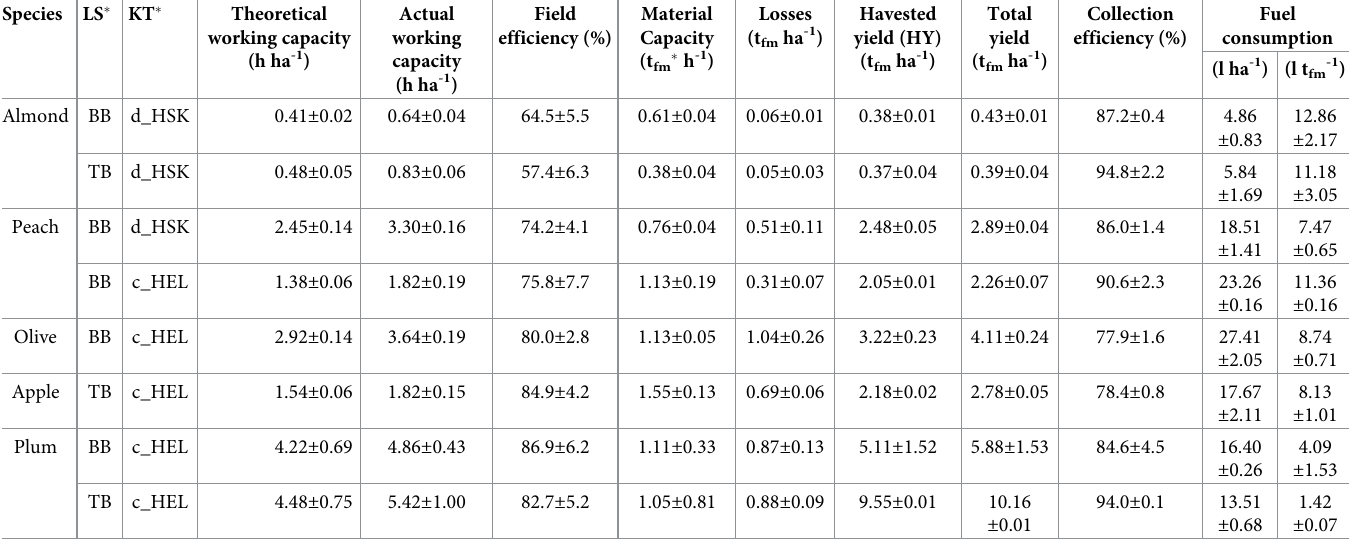
Table 4. Main results obtained during the performance harvesting tests carried out with the PC50 in Spain and Germany. See Table 5 for the analysis of the main fac- tor loading system (LS, either BB, Big Bag; or TB, Tilting Box) and knives type (KT, either d_HSK, discontinous hoe shaped knives, c_HEL, continous helicoidal knives) and their interaction by means of a general linear mixed model adapted to unbalanced datasets where plant species and Counter Rotating Rollers (CRR: V4 (1.65 Hz) for almond and olive and V3 (1.23 Hz) for Peach, Apple and Plum) were considered random factor. Data are means ± standad